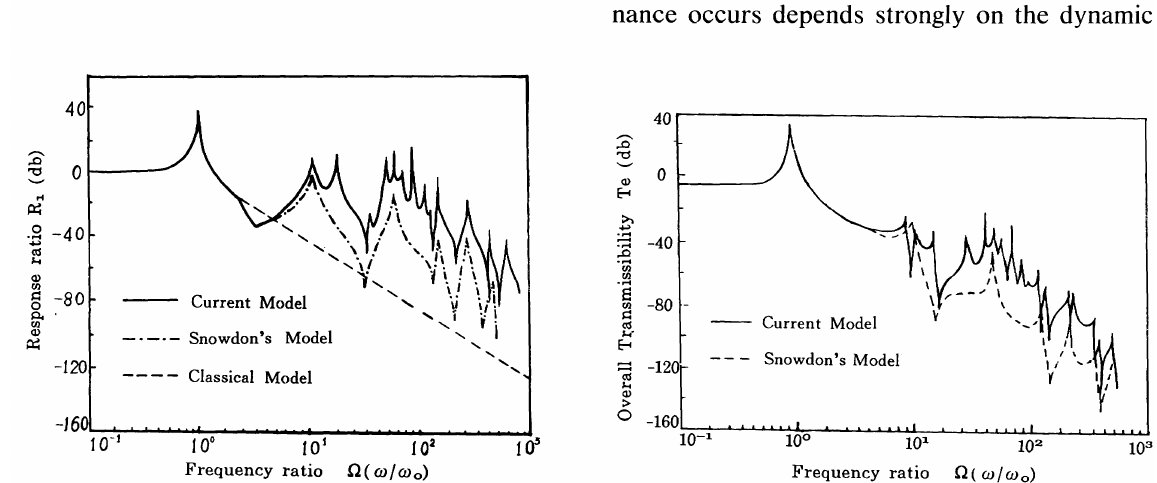
FIGURE 5 Comparison of R in three models: "II = 25, 'YJ = 0.05, a = 0.01, M1Mb = 10, A = 10.